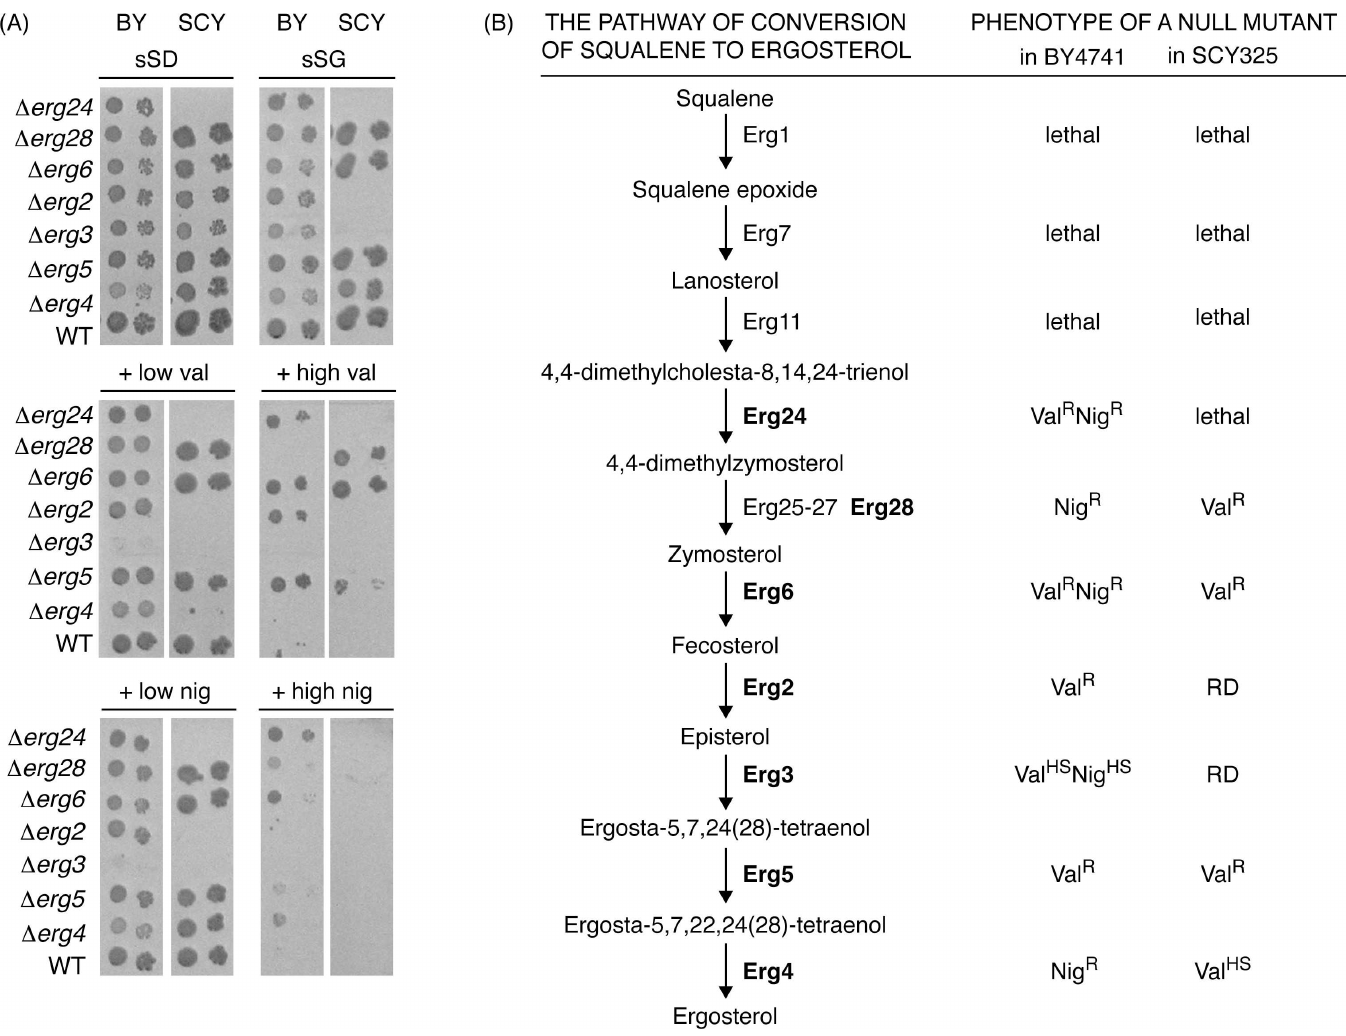
Fig 2. All viable erg mutants exhibit changes in sensitivity to ionophores in both BY4741 and SCY325 genetic backgrounds. (A) Growth of the mutant strains was assessed as describedin Fig 1 and in Materials and Methods. (B) Scheme of the pathway of conversion of squaleneto